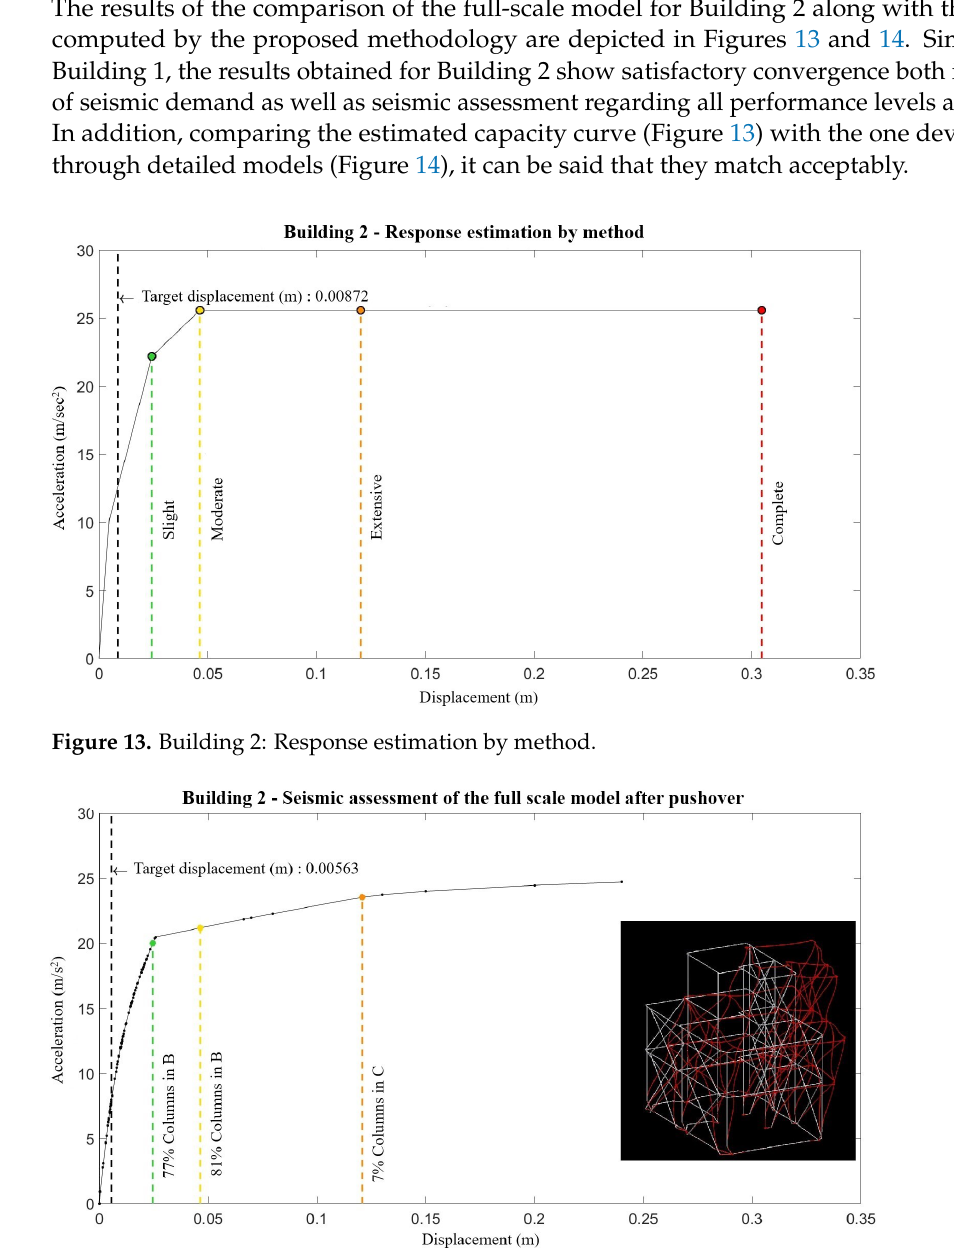
Figure 14. Building 2: Seismic assessment results of the full-scale model after